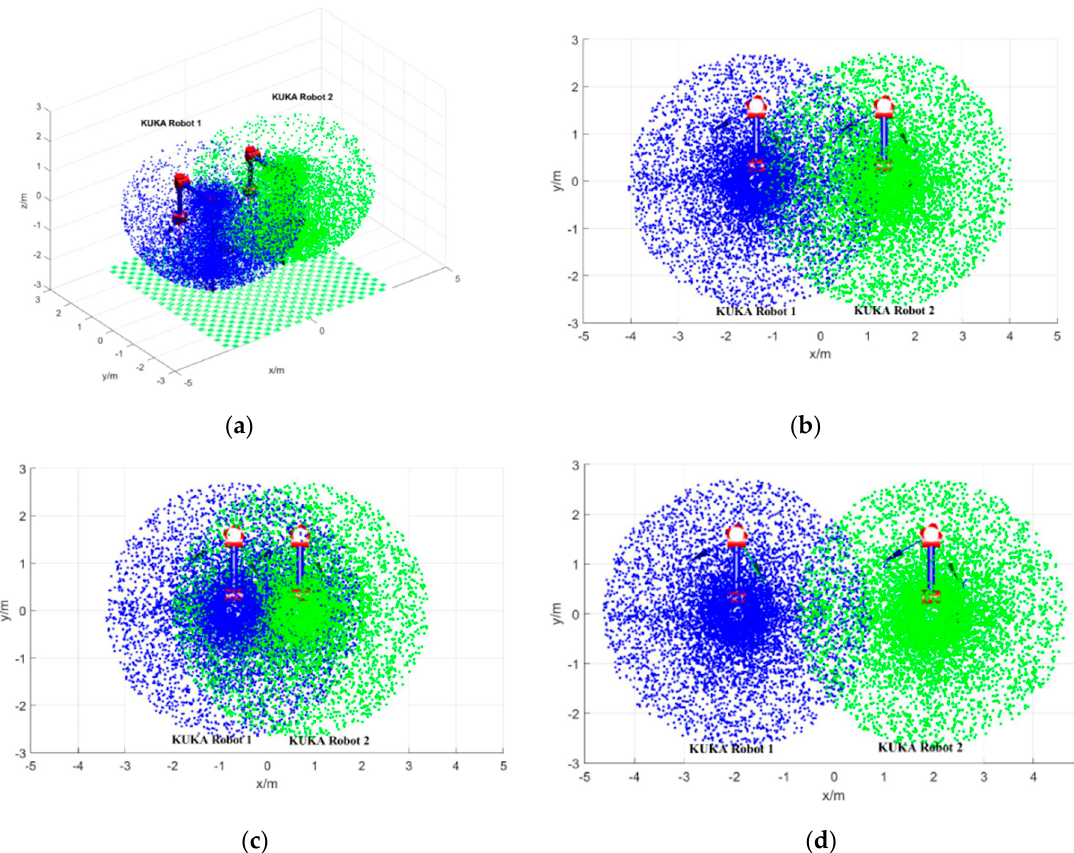
Figure 3. Point cloud diagram of two robots’ assembly range. ( a ) A 3D view of work range; ( b ) a top